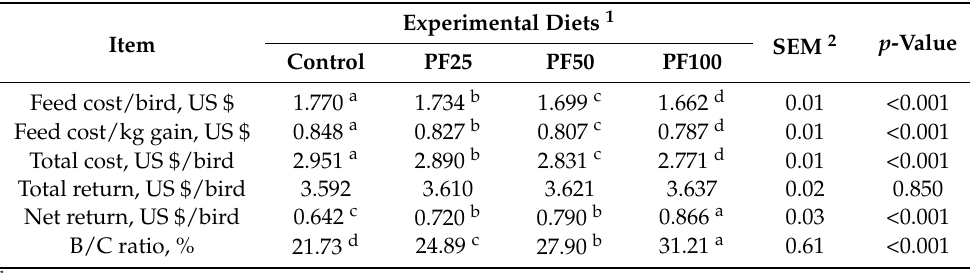
Table 7. Effect of replacing soybean oil with poultry fat on the economic